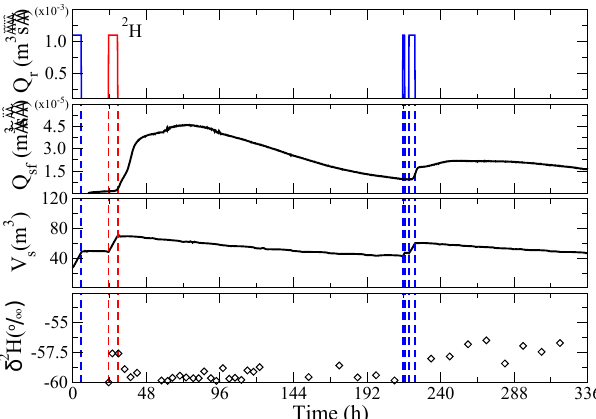
Figure 1. Hydrological response to the tracer experiment at the LEO-1 hillslope. From top: measured rain input pulses Q r (the red pulse is deuterium-enriched); seepage face flow Q sf ; total wa- ter storage V s ; and mean δ 2 H values at the seepage face. Time 0 corresponds to 09:30, 13 April 2013. The vertical dashed lines in- dicate the timing of the three pulses of rain (red when the water is deuterium-enriched and blue when it is